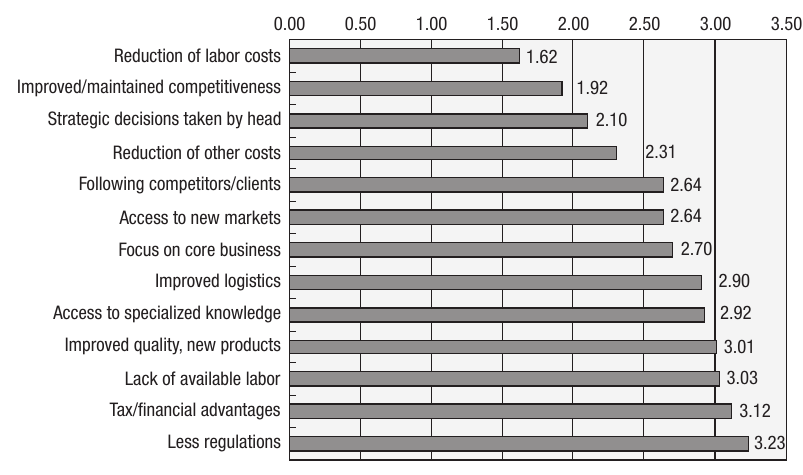
Fig. 1. Motivations for international